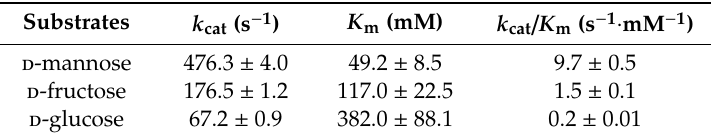
Table 3. Kinetic parameters for recombinant P. geniculata AGEase.